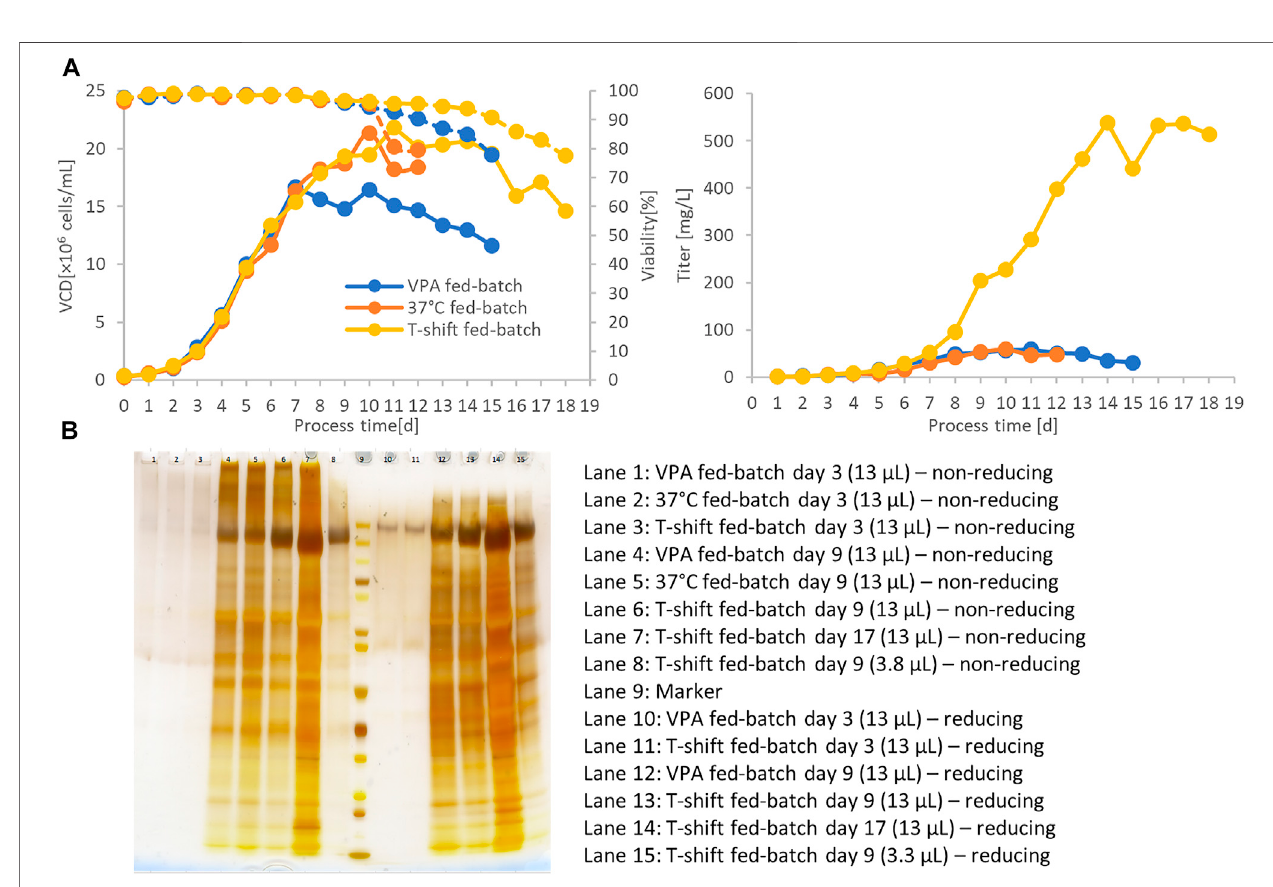
FIGURE5| 500-mlfed-batchbioreactorcultivationofthe fi nalC11cloneat37 ° C,hypothermictemperatureshiftto32 ° Corvalproicacid(VPA)addition (A) .Culture longevity and fi nal harvest titer were signi fi cantly improved by shifting to 32 ° C after day 6. Titer was measured by a quantitative ACE2/anti-His-btn ELISA setup. SDS- PAGEalsoveri fi edthesigni fi cantlyhigherexpressiontiterofhypothermicfed-batchcultivationbyanequivolumetriccomparison (B) .Samplevolumeof13 µlshowedthe enriched product band in the 32 ° C culture supernatant.